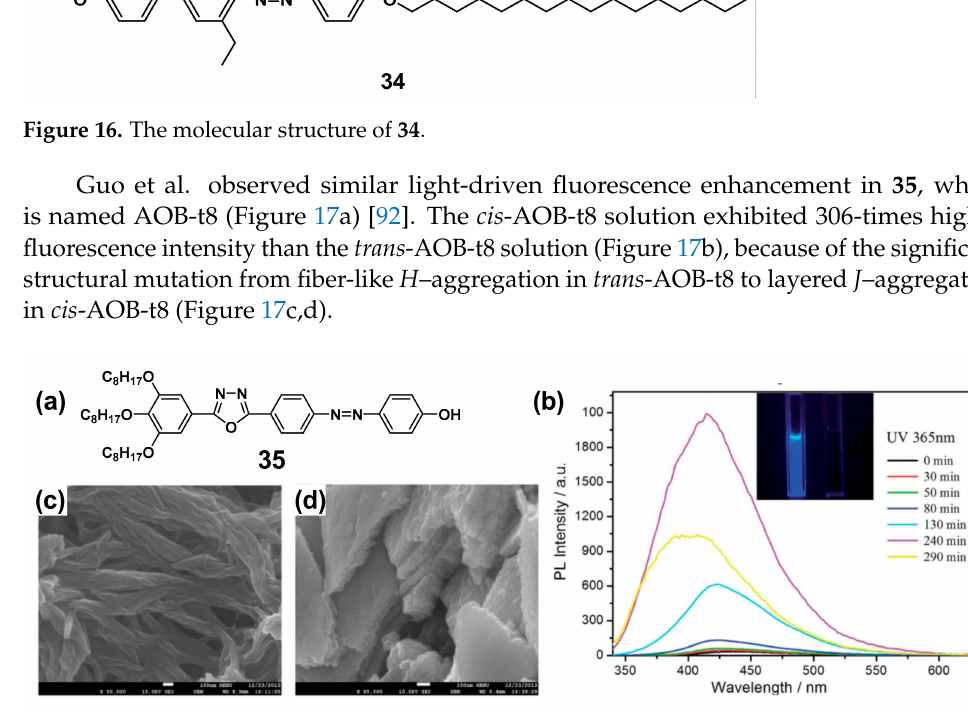
Figure 17. ( a ) The molecular structure of azobenzene derivatives 35 . ( b ) Fluorescence spectra of 35 in ethonal (1 × 10 − 3 M) under 365 nm irradiation for different times at room temperature. Inset: the image of 35 after (left) and before (right) UV irradiation. ( c , d ) SEM images of 35 in ethonal (1 × 10 − 3 M) before exposure to UV light and under irradiation at 365 nm for 290 min, respectively. ( b – d ) were reproduced with permission from [92]. Copyright 2014 The Royal Society of